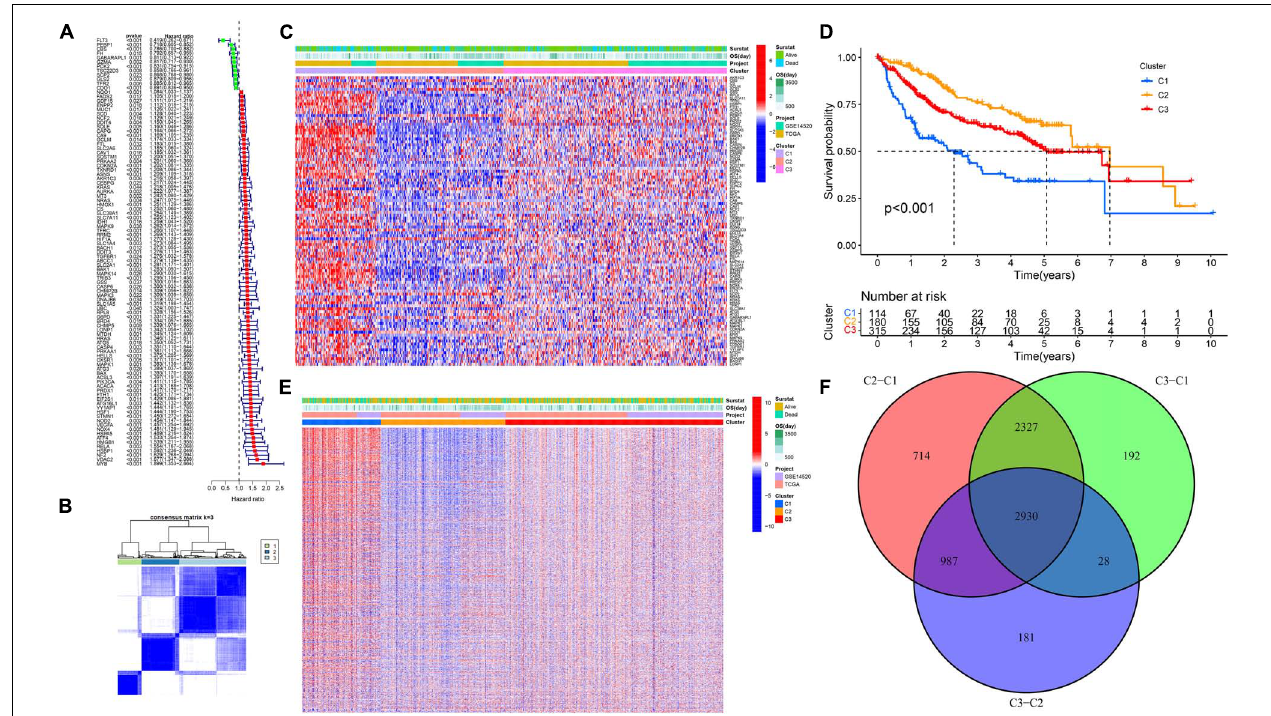
FIGURE 1 | Ferroptosis- and pyroptosis-related genes cluster analysis. (A) The forest plot of PRGs. (B,C) Cluster analysis. (D) The Kaplan–Meier survival analysis. (E) The heatmap of DEGs. (F) The Venn plot of intersection DEGs.